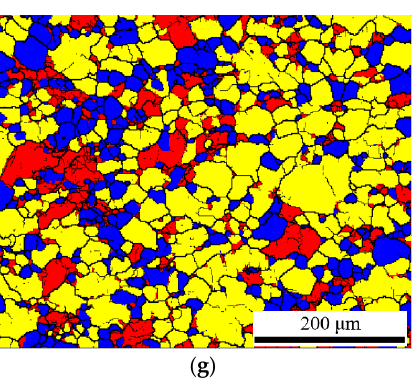
Figure 12. GAM maps of recrystallized, substructured, and deformed grains at conditions: ( a ) 673 K, 0.001 s −1 ; ( b ) 673 K, 0.01 s −1 ; ( c ) 673 K, 0.1 s −1 ; ( d ) 673 K, 1 s −1 ; ( e ) 623 K, 0.01 s −1 ; ( f ) 723 K, 0.01 s −1 ; ( g )773 K, 0.01 s −1 .